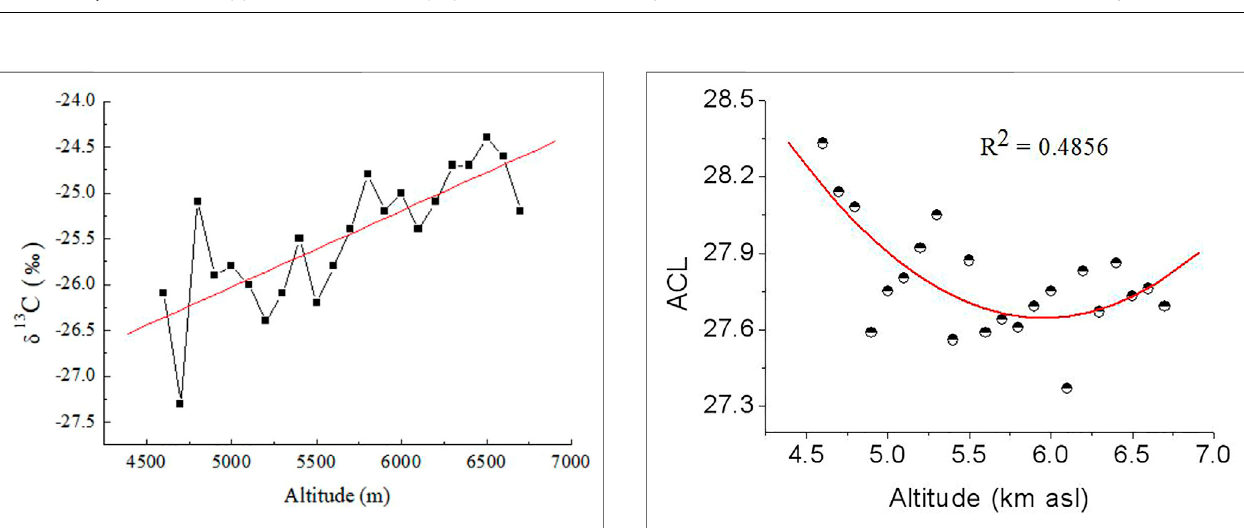
FIGURE 4 | Variation of CPI 25-31 , OEP 27 , C 21- /C 21+ , C 29 /C 31 , Pr/Ph, Pr/ n C 17 , Ph/ n C 18 , and δ 13 C of n -alkane and n -alkan-2-one in the studied samples.